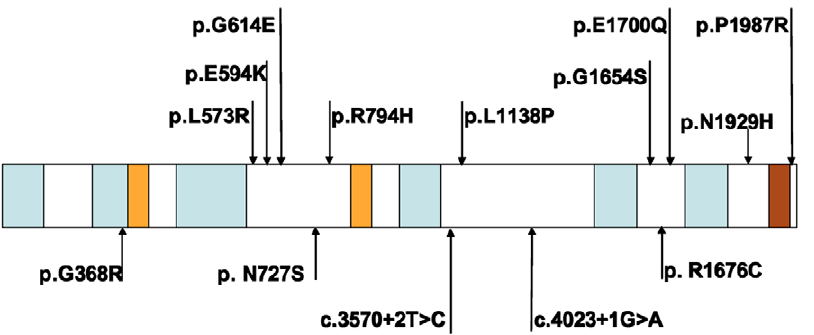
Figure 1. Novel pathogenic OTOF mutations in this work and the relation to the functional domains [ 42 ] . Blue: 6 C2 domains. Orange: FerI and FerB domains. Brown: transmembrane domain. Variations of this work are noted under the schematic diagram, and other missense mutations outside the function domains are shown above it.